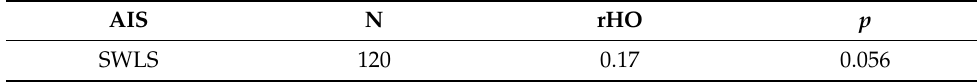
Table 9. Satisfaction with life versus acceptance of illness.